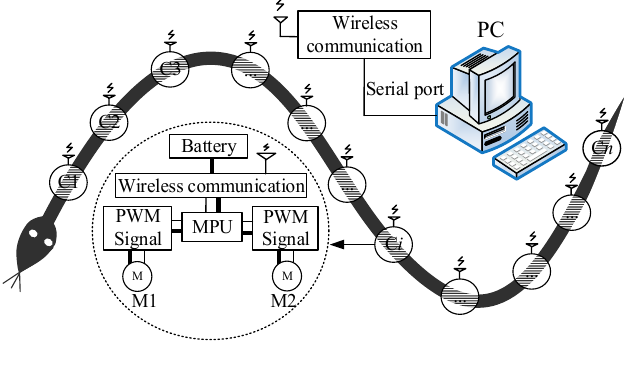
Figure 7. Control system.